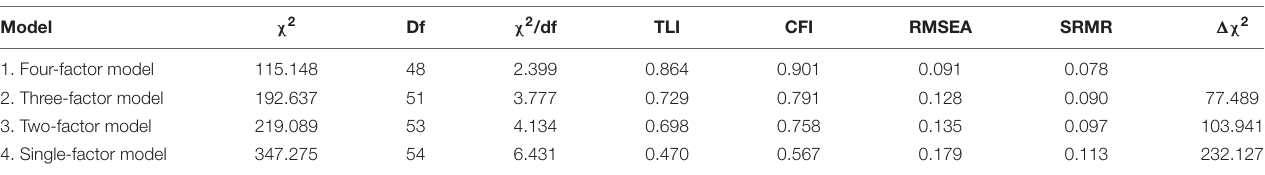
TABLE 2 | Model fit results for confirmatory factor analyses. Model